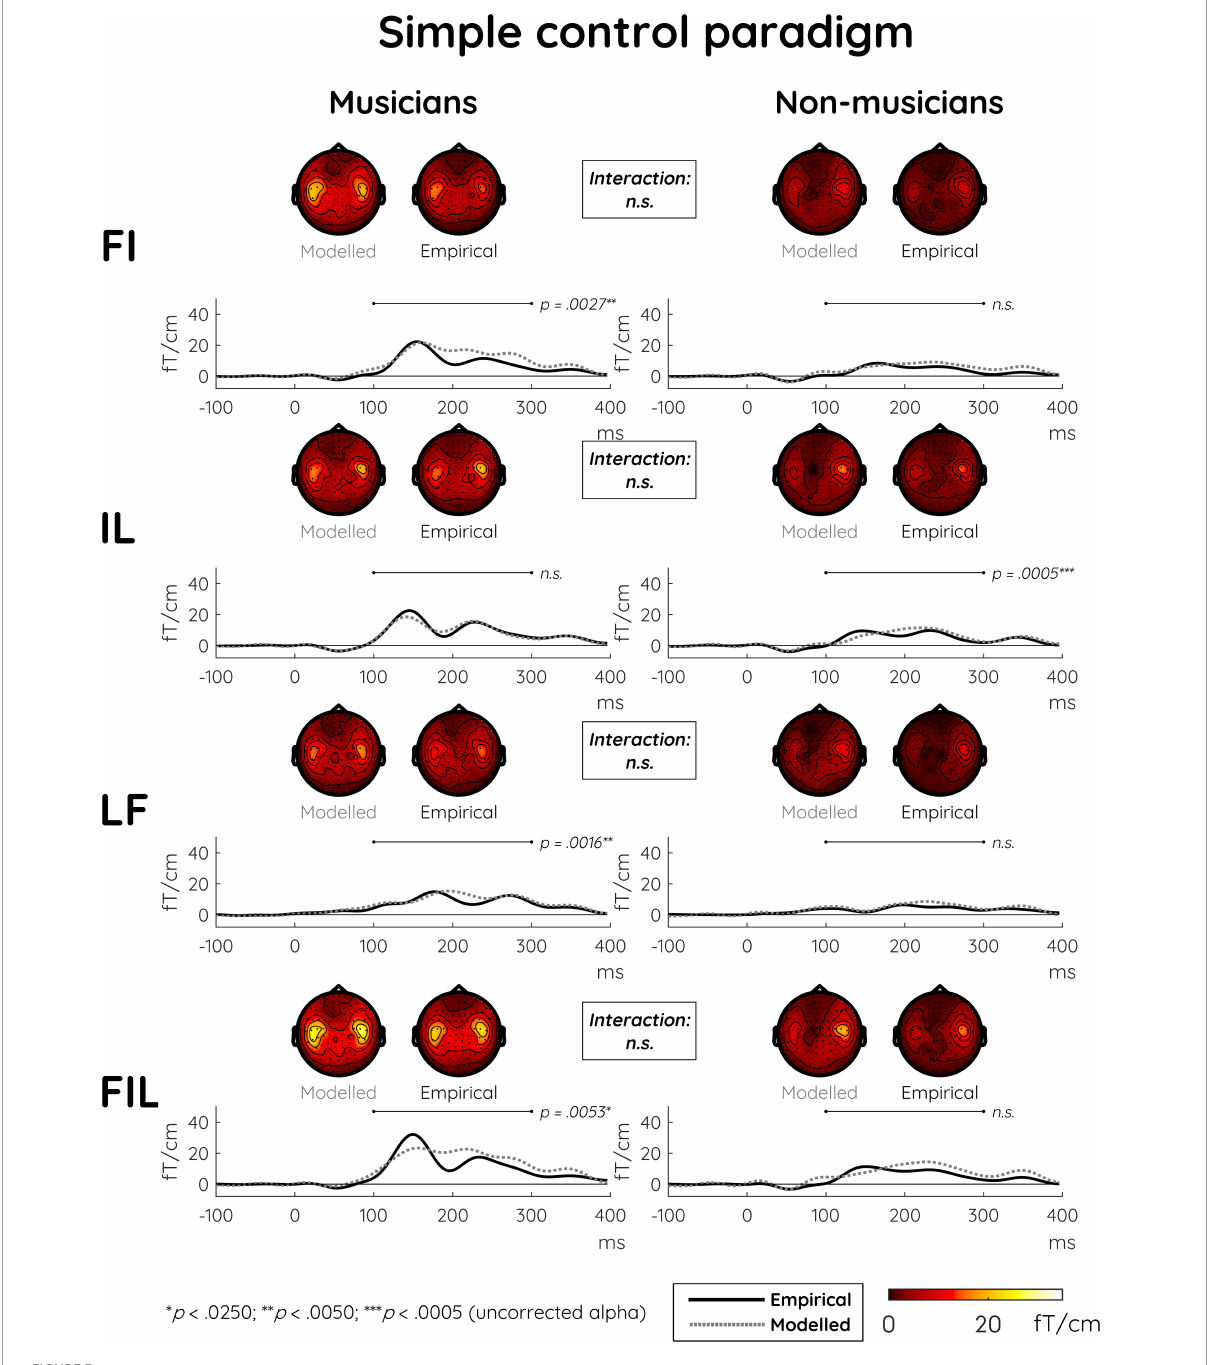
FIGURE3 Modeled and empirical mismatch negativity (MMNm) in musicians and non-musicians in the simple control paradigm in response to double deviants differing in either frequency and intensity (FI), intensity and location (IL), or location and frequency (LF), as well as to triple deviants differing in frequency and intensity and location (FIL). Modeled MMNms (dashed gray lines) correspond to the sum of MMNms to two or three single deviants whereas empirical MMNms (solid black lines) correspond to the actual MMNms obtained with double and triple deviants. In contrast to the musical multi-feature paradigm, there were no significant differences in additivity between musicians and non-musicians when comparing the modeled and empirical MMNms. The event-related field (ERF) plots depict the mean of the data from the peak sensor and eight surrounding sensors in each hemisphere [the peak gradiometer pairs were MEG1342 + 1343 (Right) and MEG0242 + 0243 (Left) ]. Low-pass filtering at 20 Hz was applied for visualization purposes only. The topographical distributions depict the 100–300 ms post-stimulus time range for the difference waves between standard and deviant responses, and p -values reflect simple effects of additivity separately for musicians and